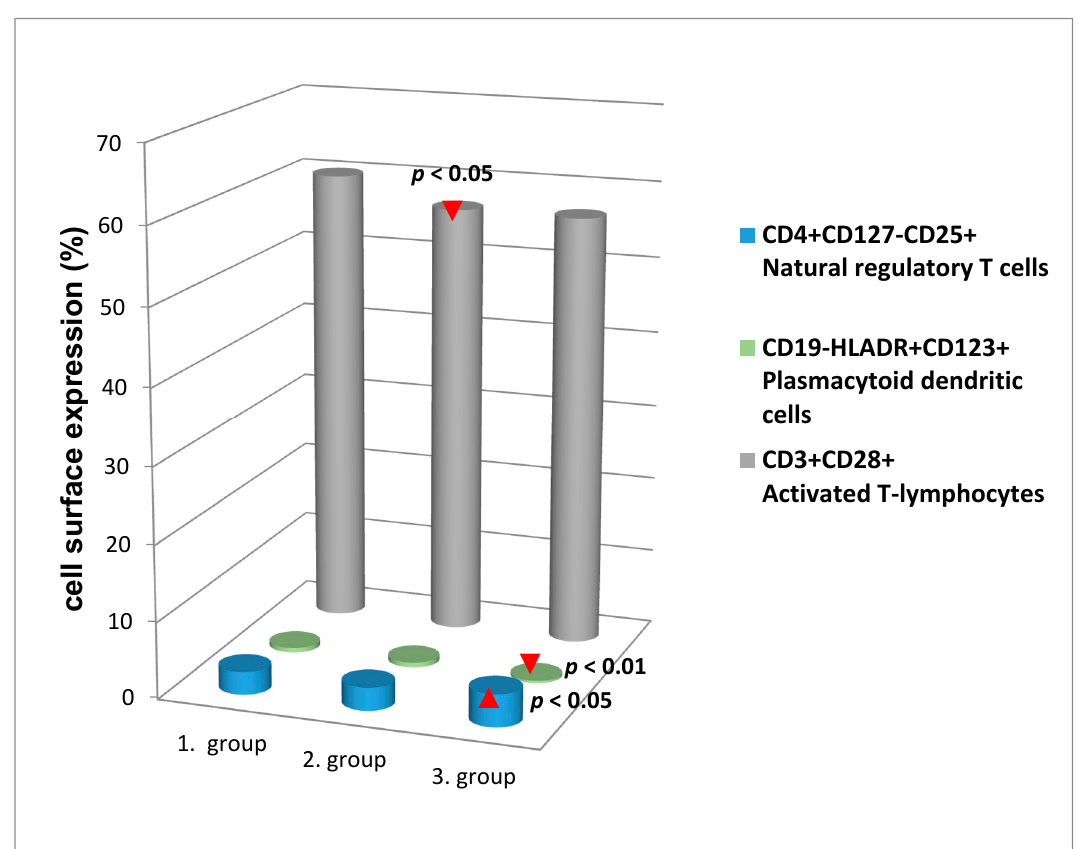
Figure 2. Significant changes of the cell surface expression between women with different bone mineral density. BMD = bone mineral density, 1. group = normal BMD ( n = 126); 2. group = osteopenia ( n = 62); 3. group = osteoporosis ( n = 11).